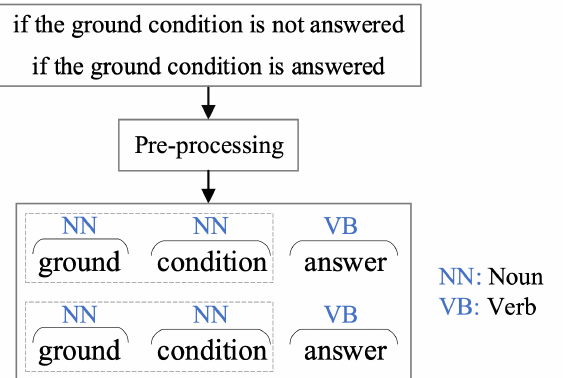
Figure 3. The part-of-speech tagging of the conditional